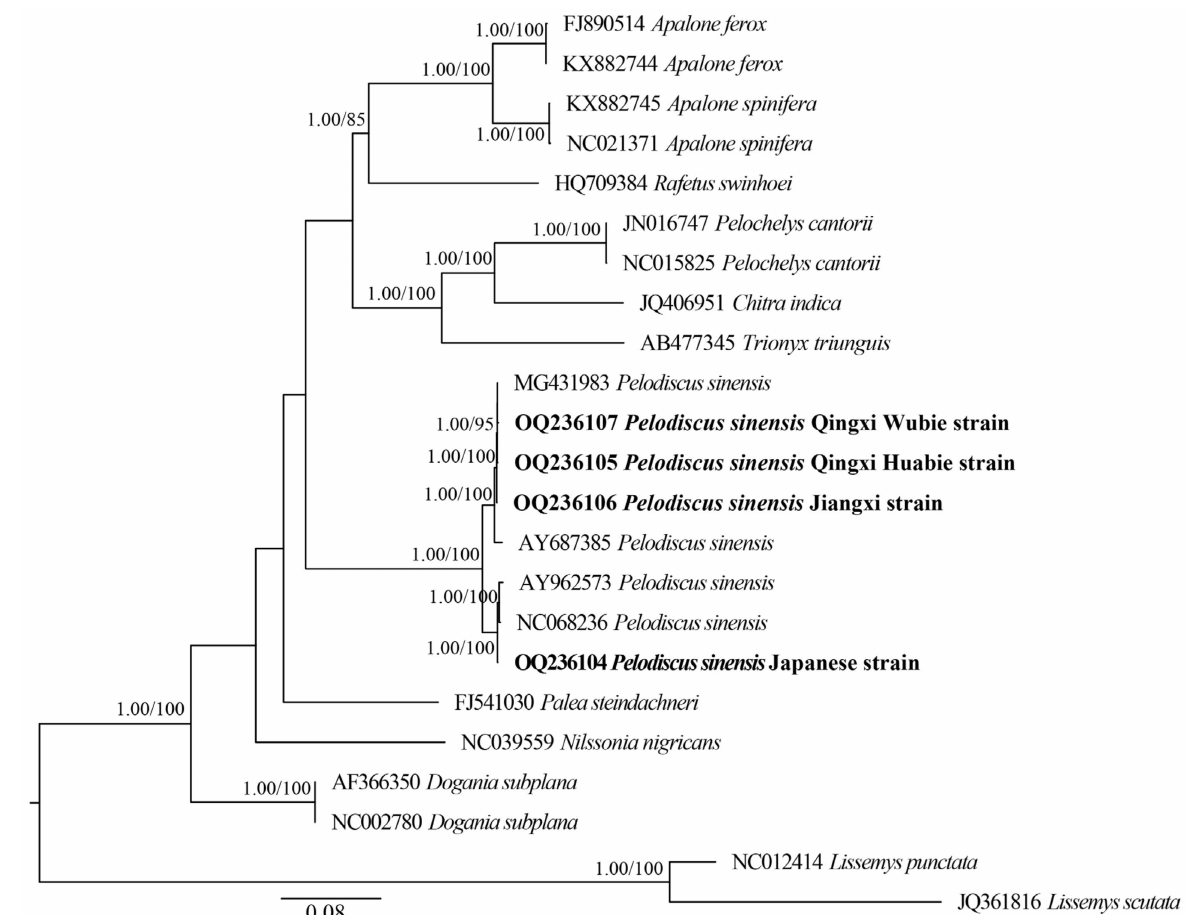
Figure 8. Molecular phylogenetic analysis of Trionychidae species using BI and ML methods based on concatenated mtDNA datasets . The phylogenetic tree nodes were considered well sup- ported when the Bayesian posterior probability (BPP) of the node was ≥ 0.95 and ultrafast bootstrap was ≥ 80%. Numbers beside the nodes represent BPP (left) and bootstrap values (right). The bold fonts indicate the four P. sinensis strains sequenced in this